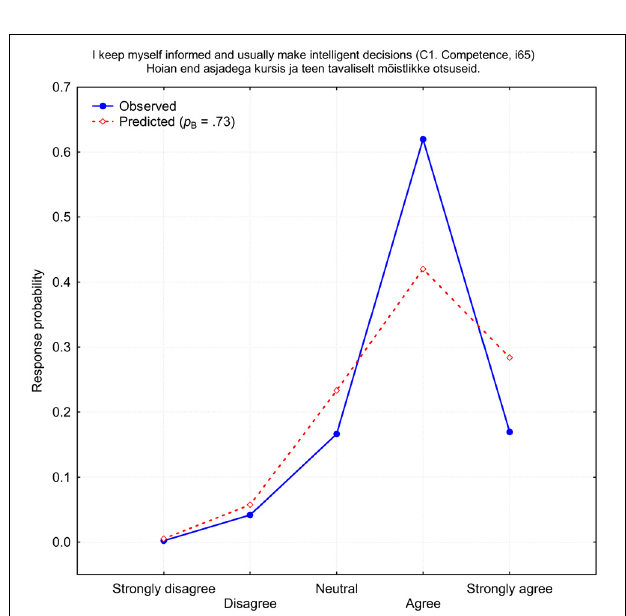
FIGURE 7 | Observed (blue) and predicted (red) response probabilities of the self-rated item i 65 (C1: